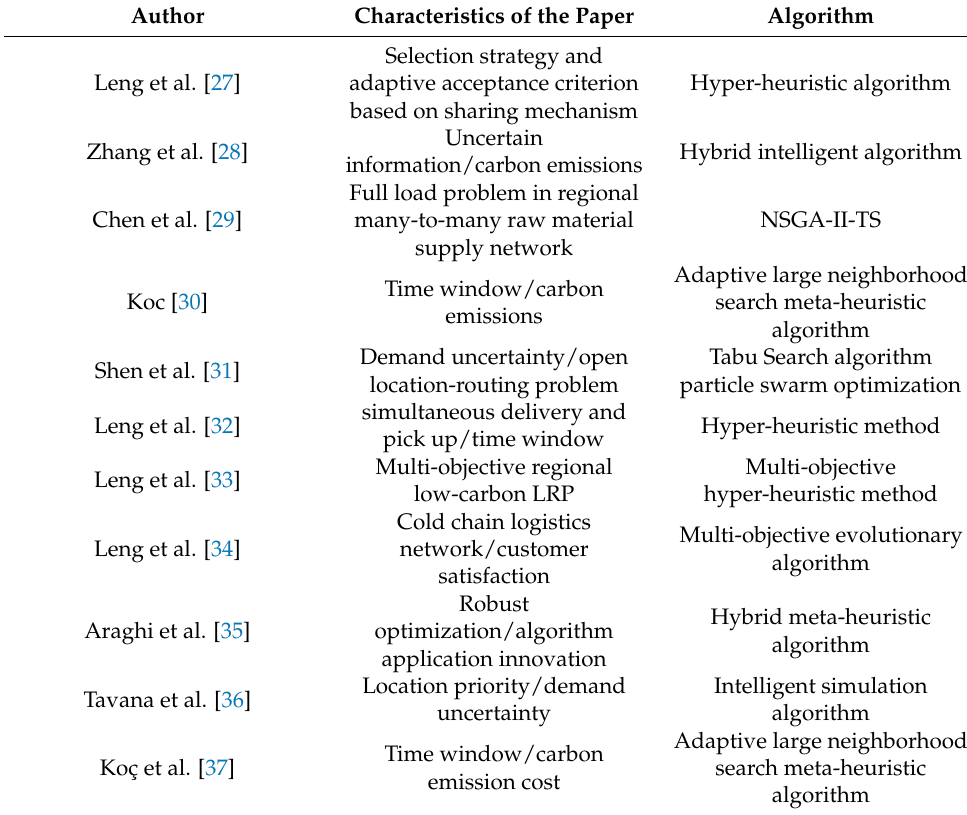
Table 1. Review of articles on LRP considering carbon